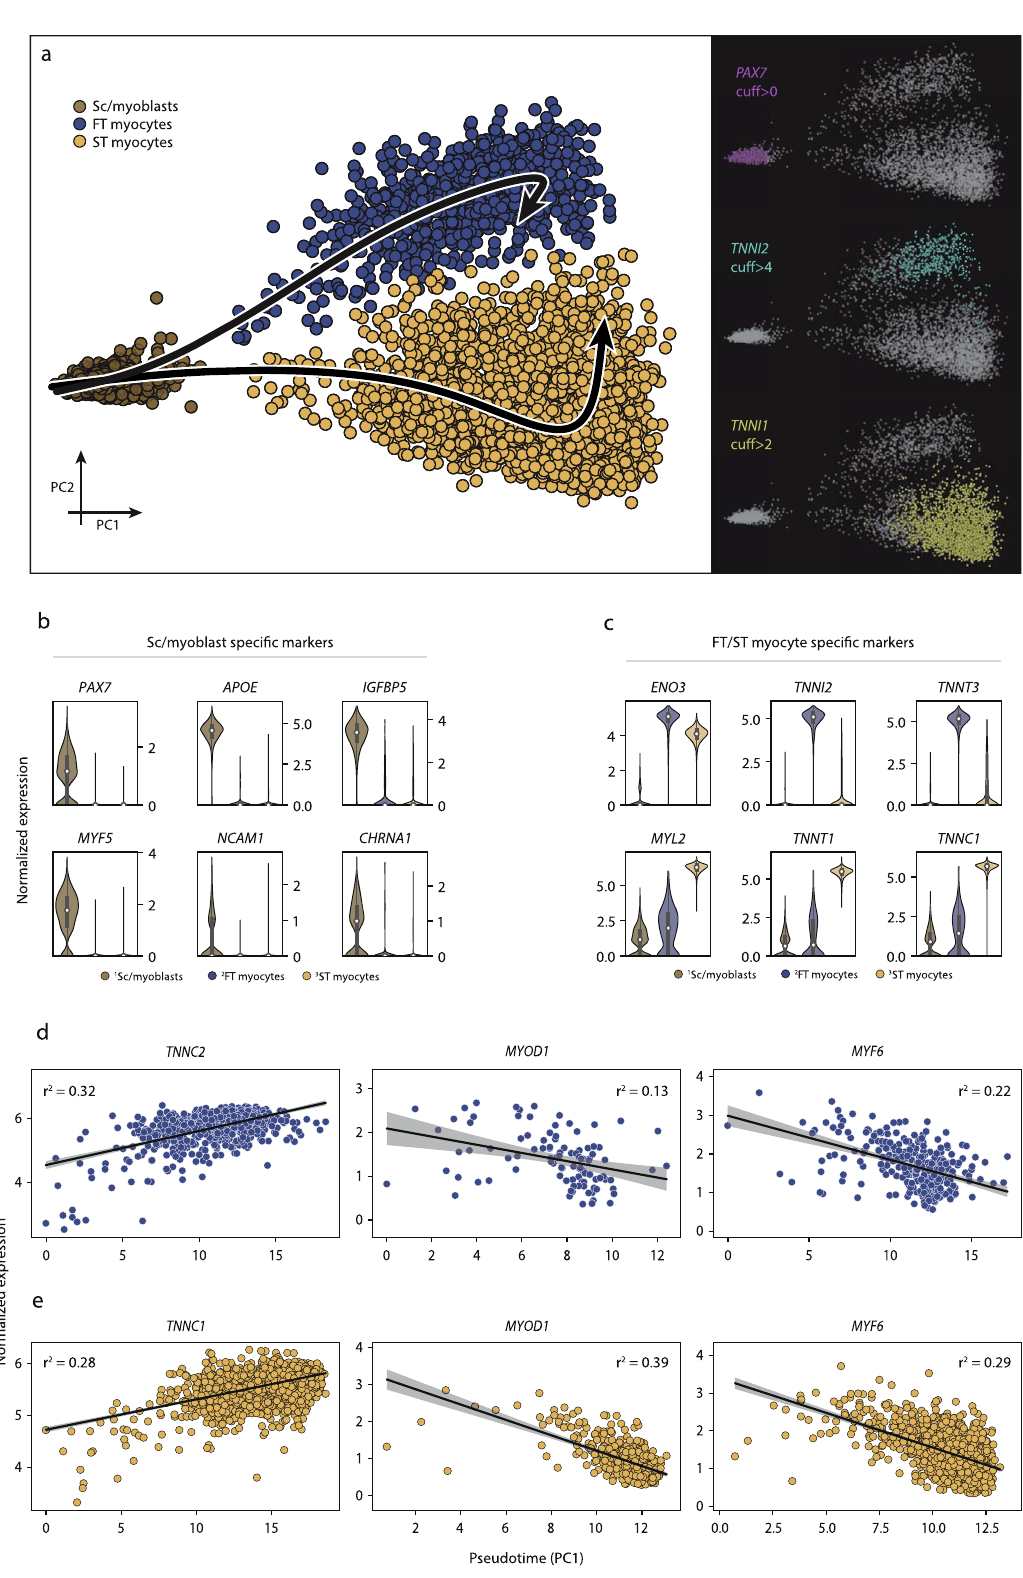
driving the regenerative response included ACTB , TPM1 , TIMP3 , and CD36 . In terms of the greatest exercise-related response, the pericytes differentially expressed ACTB and ACTA2 after exercise (Fig. 3h). A complete list of differentially expressed genes and ontologies across cell-populations can be found in Supplementary Data 5 –